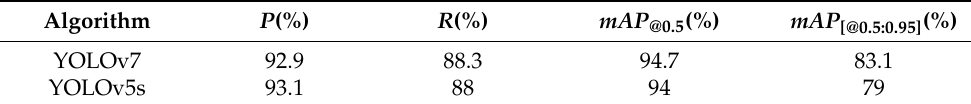
Figure 10. Precision-recall curves graphs. ( a ) YOLOv7, ( b ) YOLOv5s. Table 1. Performance comparison of different detection algorithms.